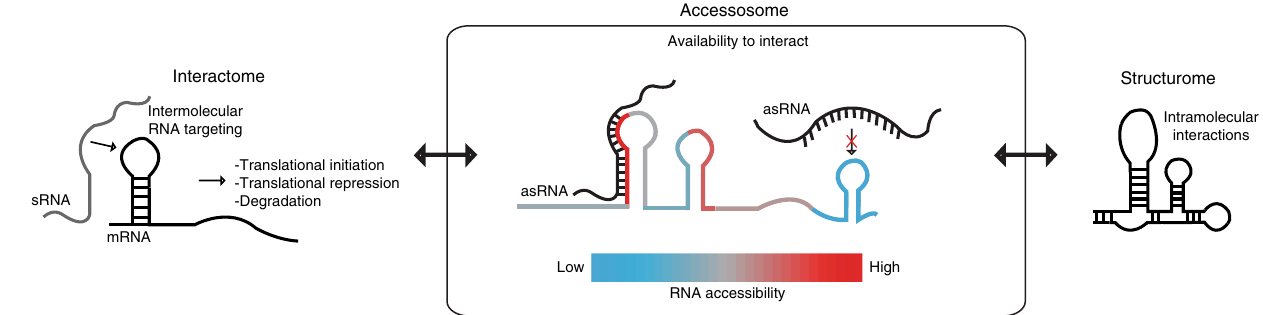
Fig. 8 INTERFACE sits at the core of the structure – function relationship. By sensing functional hybridization differences attributed to both in vivo interactions (interactome, left) and secondary structure (structurome, right), the accessosome offered by INTERFACE sits at the core of the structure –